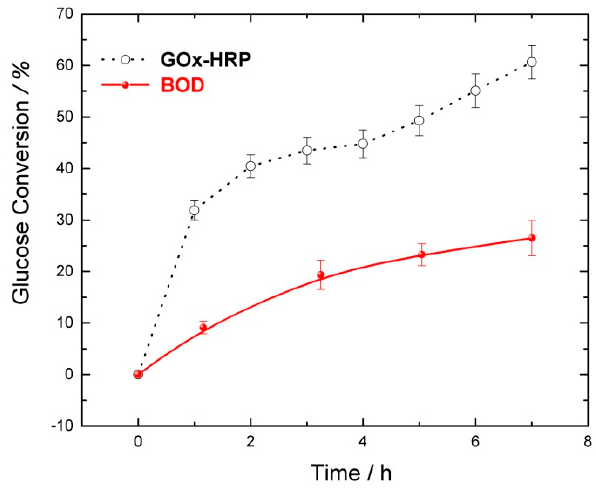
Figure 8. Comparison of glucose conversion in two di ff erent reactors.